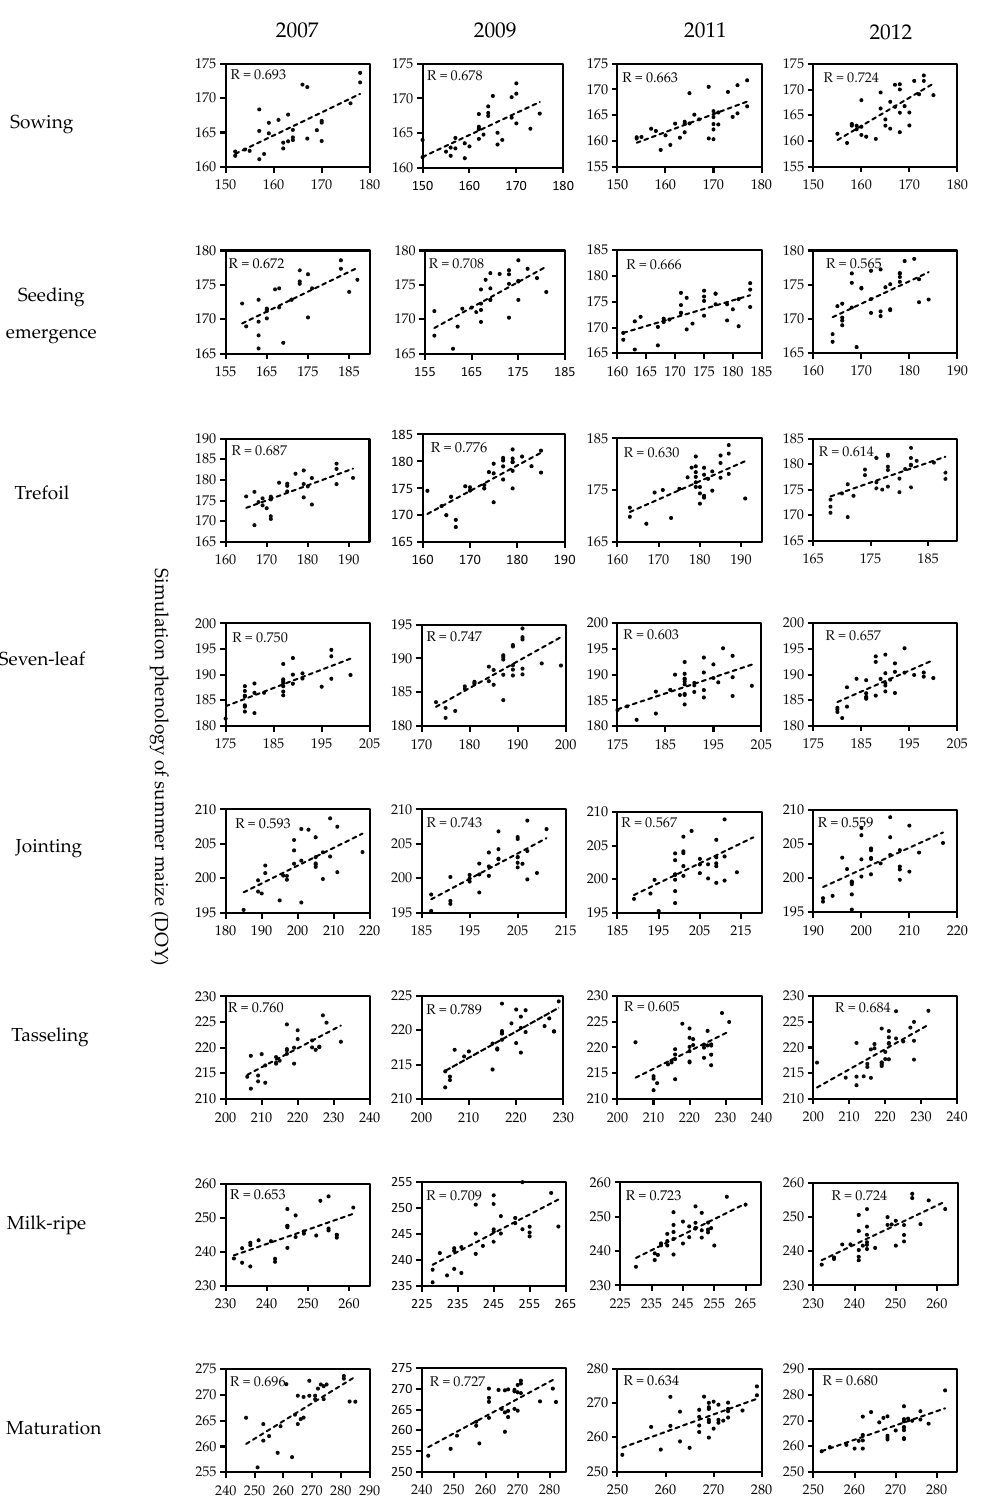
The actual phenology of summer maize (DOY) Figure 7. Correlation between actual summer maize phenology and simulated summer maize Figure7. Correlationbetweenactualsummermaizephenologyandsimulatedsummermaizephenology phenology with environmental factors in Huanghuaihai Plain in 2012. with environmental factors in Huanghuaihai Plain in